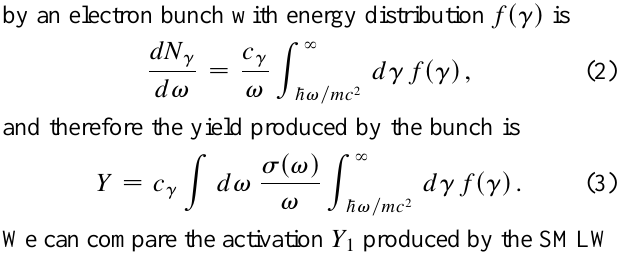
Fig. 17. Evaluating Eq. (3) for the distributions shown in Fig. 17 we find Y 2 (cid:3) Y 1 (cid:6) 40 for the reaction 63 Cu (cid:1) g , n (cid:2) , and Y 2 (cid:3) Y 1 (cid:6) 4.2 3 10 2 for the reaction 63 Cu (cid:1) g , 2 n (cid:2) .